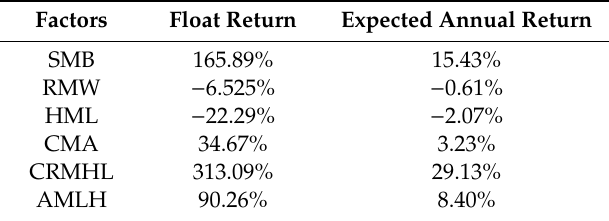
Table 7. Back-testing float return from 2007S4 to 2018S3 and expected annual return for